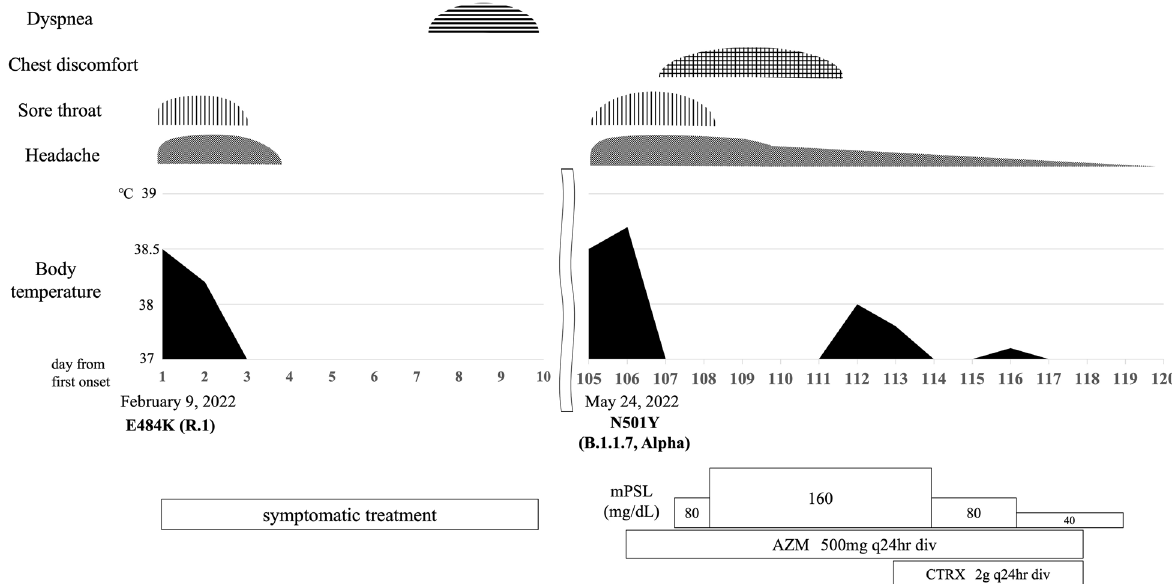
Fig. 1 The course of symptoms and treatments from infection with the E484K variant to infection with the N501Y variant. The severity was mild in both the initial infection (E484K variant) and the reinfection (N 501Y variant). In the initial infection, he was relieved in about 3 to 4 days with only symptomatic treatment, but in the reinfection, his fever was bimodal, and he had persistent symptoms. Abbreviations: methylprednisolone, mPSL; azithromycin, AZM; ceftriaxone,